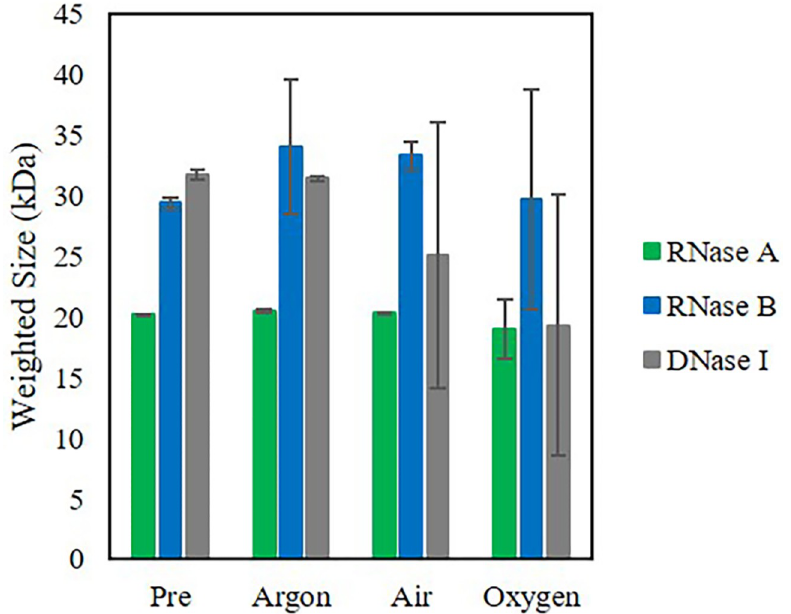
Fig 4. Weighted size (kDa) of RNase A, RNase B, and DNase I. Weighted size post purging and subsequent microwave irradiation of 30% power, 60 seconds. In general, as oxygen content increases, the overall weighted nuclease size decreases and the error in the size becomes larger. This in indicative of an increasing number of varying size fragments with an overall degraded nuclease. Pre = No microwave irradiation.